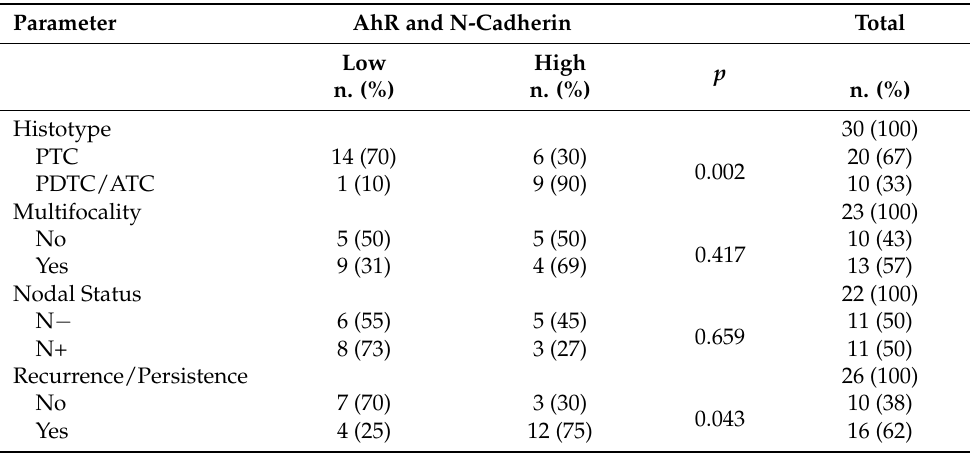
Table 6. Associations between tumours examined according to the concurrent expression of AhR and N-cadherin and clinical–pathological